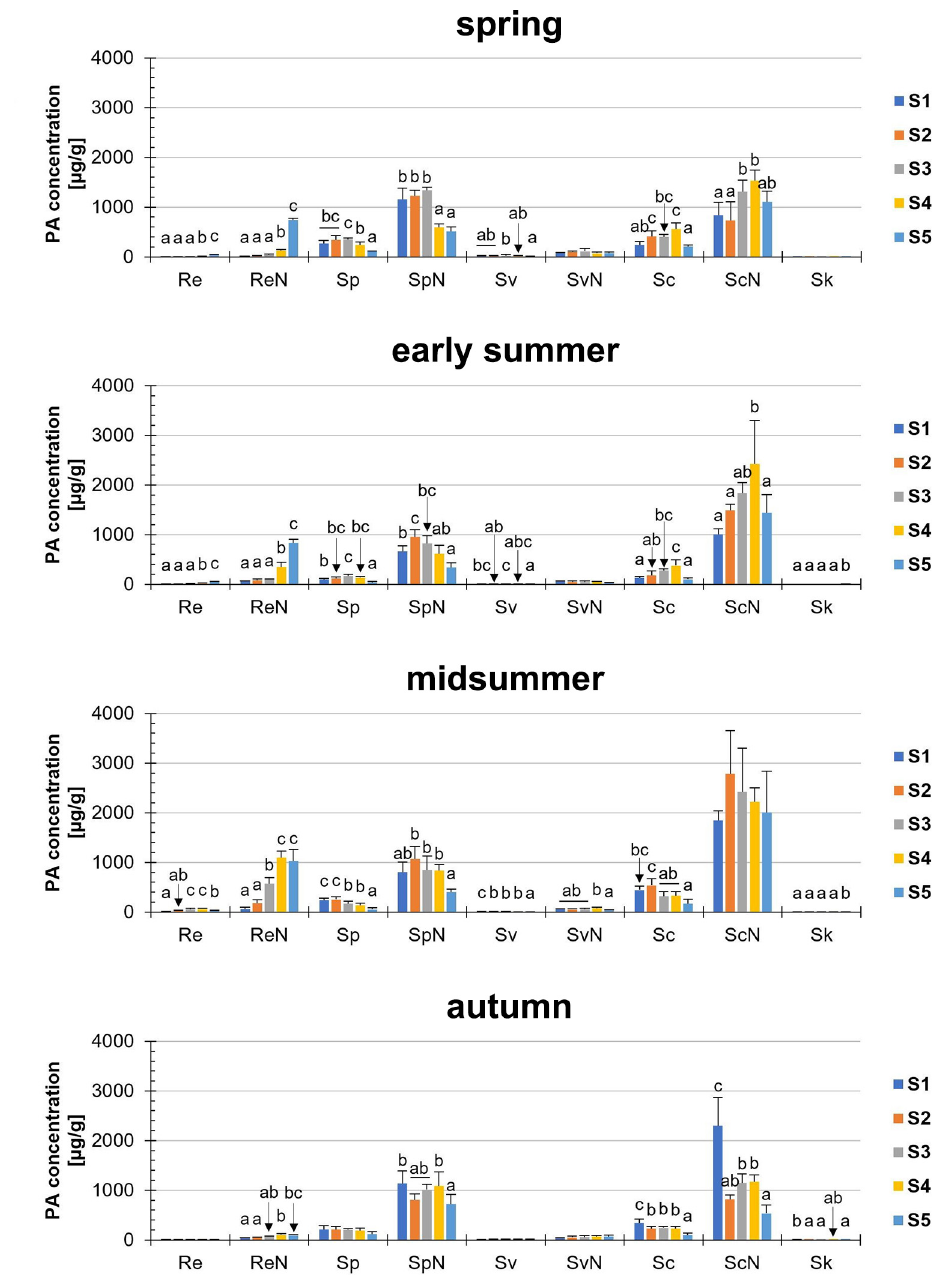
Figure 4. PA concentration ( µ g/g dm) of nine different PAs in Senecio vulgaris L. plants depending on the developmental stage (S1 to S5) and season. Results are means ± SD of five different determinations (distinct sub-trials, see Supplemental Figures S2 and S3). Different letters identify significant differences ( p < 0.05) between developmental stages (ANOVA, Tukey’s honest significance difference). Data for Re, Sv, Sk and SvN are shown in a different scaling in Supplemental Figure